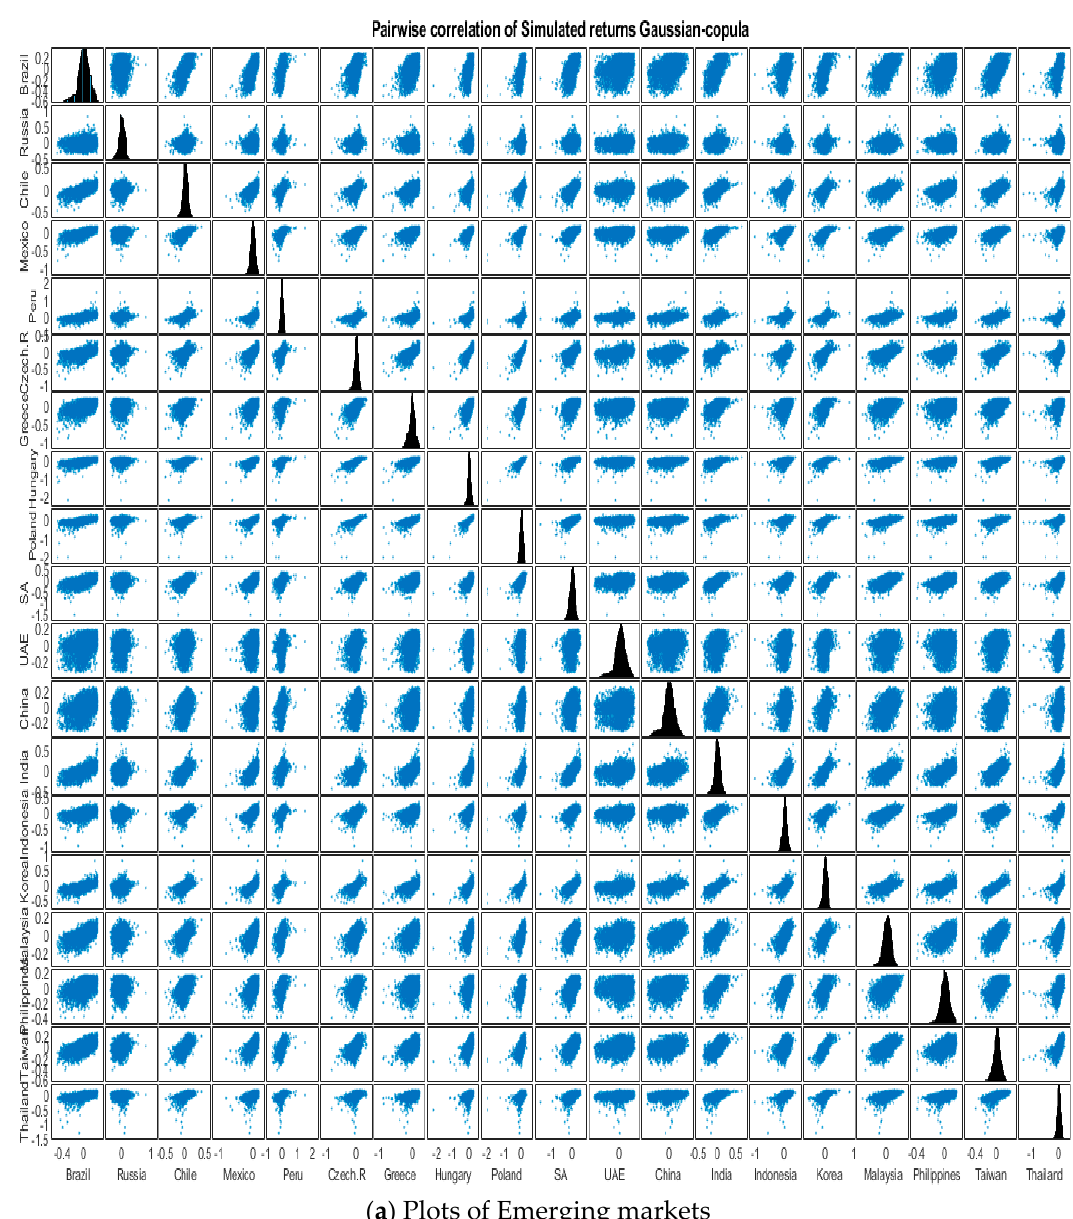
( a ) Plots of Emerging markets Figure 5.